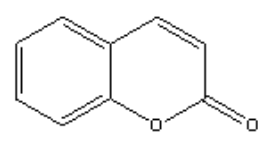
Figure 6. Coumarin for lettuce bioassays